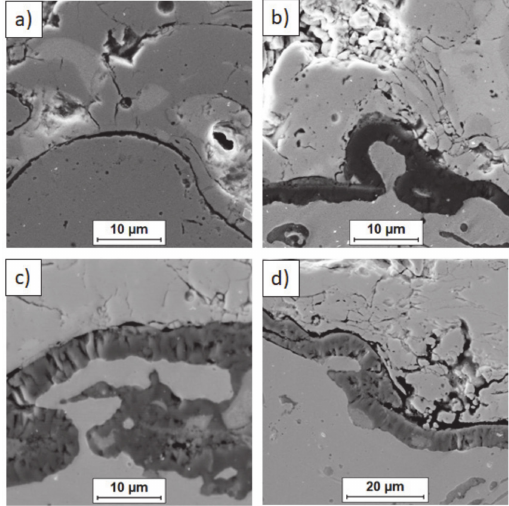
Figure 15. Ceramic layer / bond-coat interfaces of TBC systems after 500 h of oxidation at a temperature of 1100 ◦ C—composite 50% La 2 Zr 2 O 7 + 50% 8YSZ TBC (SEM): ( a , b ) zone of the bond-coat top and ( c , d ) zone of the bond-coat